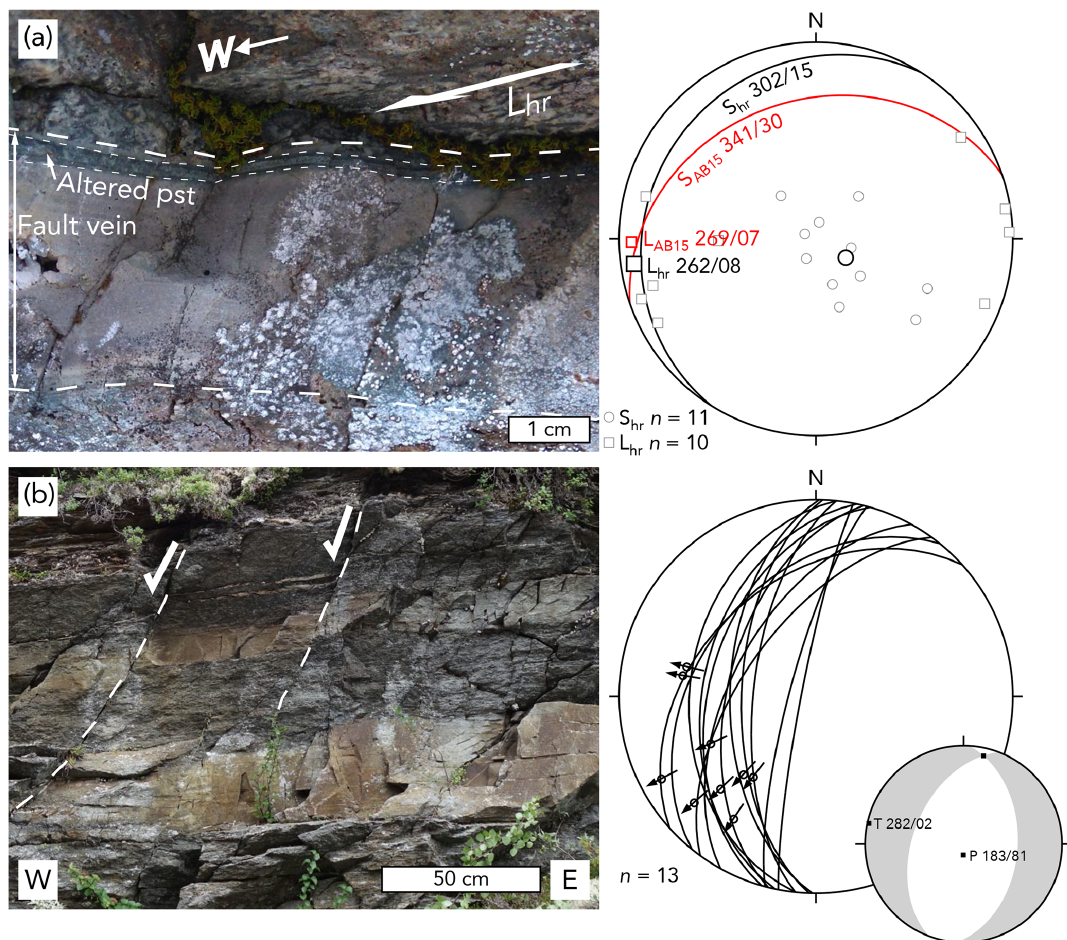
Figure 2. (a) Field photograph of the microstructurally investigated fault vein. It is 3cm wide, foliation-parallel and exhibits a 5mm thick band of bluish, altered pseudotachylyte at its top. Note the crosscutting, steeply dipping fractures. Equal-area projections with poles to host rock schistosity planes (S hr ), host rock lineations (L hr ) and orientation of the investigated sample AB15 (red great circle). Mean orientations for S hr and L hr are indicated with large symbols. (b) Brittle, steeply W-dipping normal faults crosscut the ductile fabric. Sense of slip is indicated by calcite slickenfibers on some of the fault planes. Fault plane solution for these faults (b) shows E–W extension (data processed with FaultKin 7; Marrett and Allmendinger,